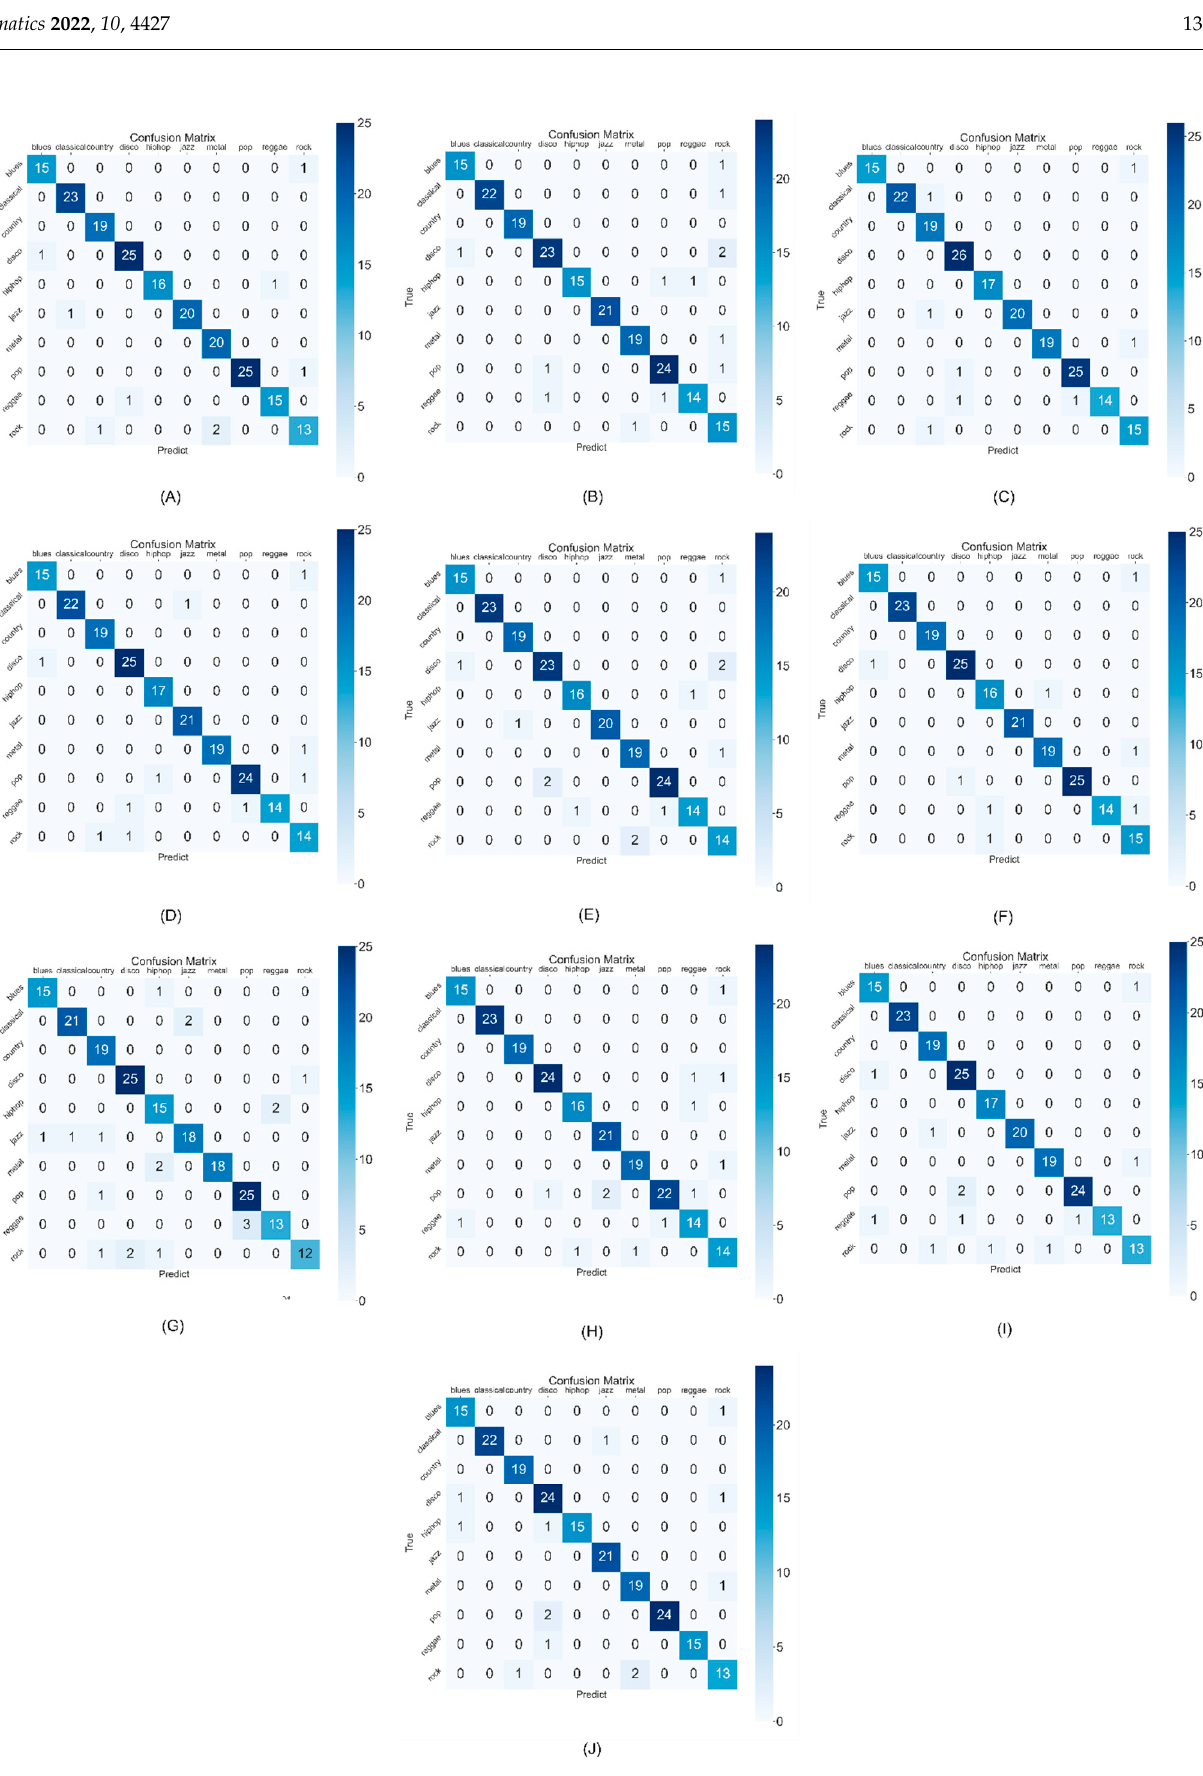
Figure 10. Confusion matrix of the experiment s .